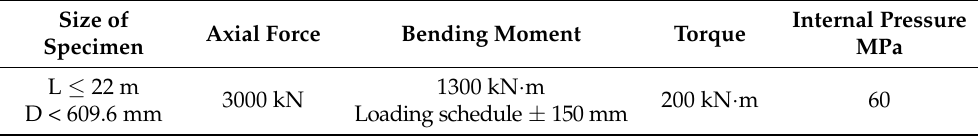
Table 2. Loading capacity of a full-scale steel catenary riser fatigue test system. Size